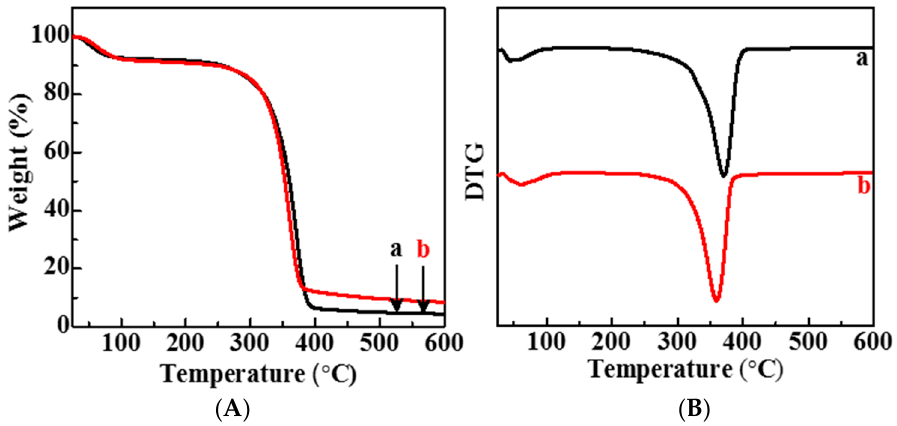
Figure 4. ( A ) TGA and ( B ) DTG analysis of PC (a) and PC 5 (b) films.